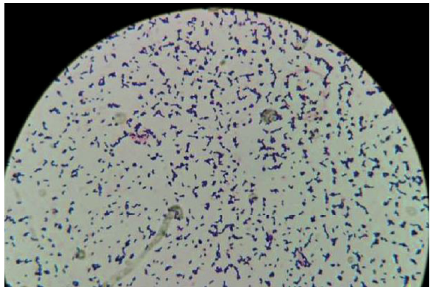
Figure 2: L. pseudomesenteroides and microscopic image. Arrows indicate blue-purple changes in Gram stain microscopically, a full fi eld of it.